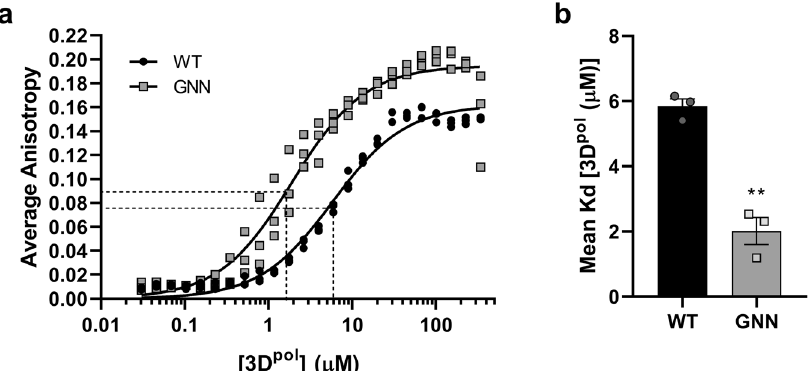
Fig. 1 RNA binding af fi nity. Fluorescence polarisation anisotropy (FPA) to determine RNA binding af fi nities of recombinant 3D pol -WT and 3D pol -GNN. a Binding of FITC-labelled 13mer poly-A RNA to recombinant 3D pol calculated as average anisotropy after 30 min incubation. b Mean Kd values comparing the af fi nity of 3D pol -WT and 3D pol -GNN with 13mer FITC-labelled poly-A RNA ( n = 3 ± SEM, analysed by interpolation of a standard curve, two-tailed unpaired t-test, ** p < 0.01).